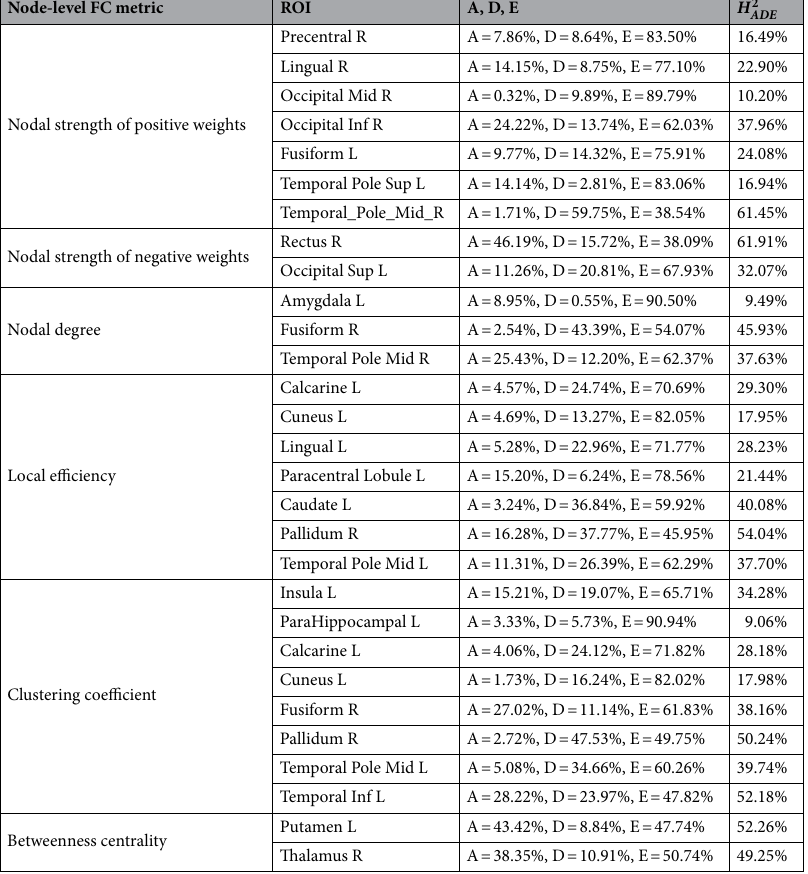
Table 3. Location of ADE factor influences on node-level FC metrics reported for each ROI in which ADE model was applicable, and the corresponding ADE coefficients and “broad-sense” heritability estimates. Orb, orbital part; inf, inferior part; mid, middle or median part; sup, superior part, r, right; l, left; post, posterior part; ant, anterior part. H 2 ADE , “broad-sense” heritability